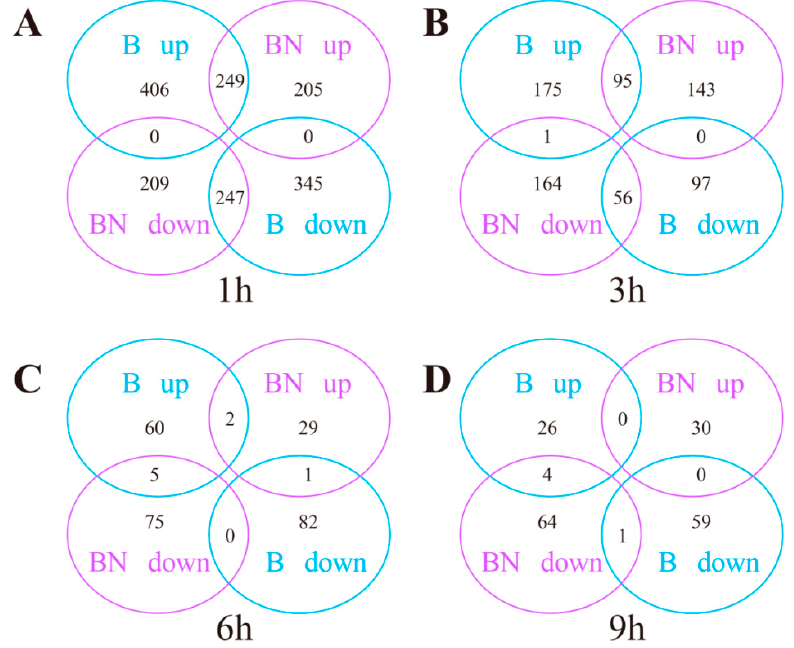
Figure 1. Venn diagrams showing DEGs in different comparison groups. The expression levels of B-1h, B-3h, B-6h, and B-9h, were compared to those of B-0h, while the expression levels of BN-1h, BN-3h, BN-6h, and BN-9h were compared to those of BN-0h, respectively. The up- and downregulated DEGs were identified by fold changes higher than 2.0 or lower than 0.5. ( A ) DEGs identified by comparing expression levels of B-1h and BN-1h. ( B ) DEGs identified by comparing expression levels of B-3h and BN-3h. ( C ) DEGs identified by comparing expression levels of B-6h and BN-6h. ( D ) DEGs identified by comparing expression levels of B-9h and